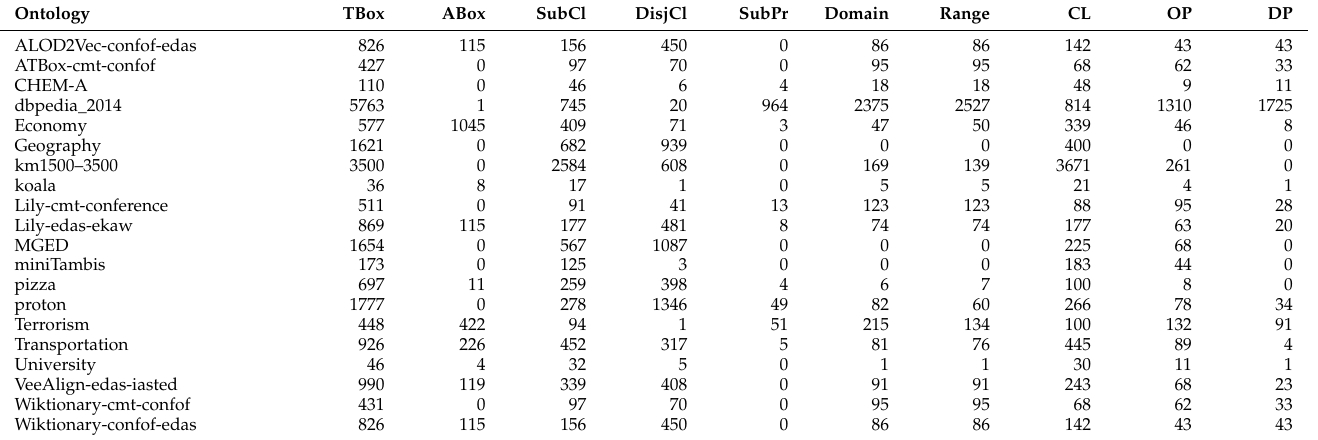
Table 2. Ontology information, where “SubPr” indicates the number of SubObjectPropertyOf axioms, “Cl”, “OP” and “DP” mean classes, object properties and data properties, respectively.